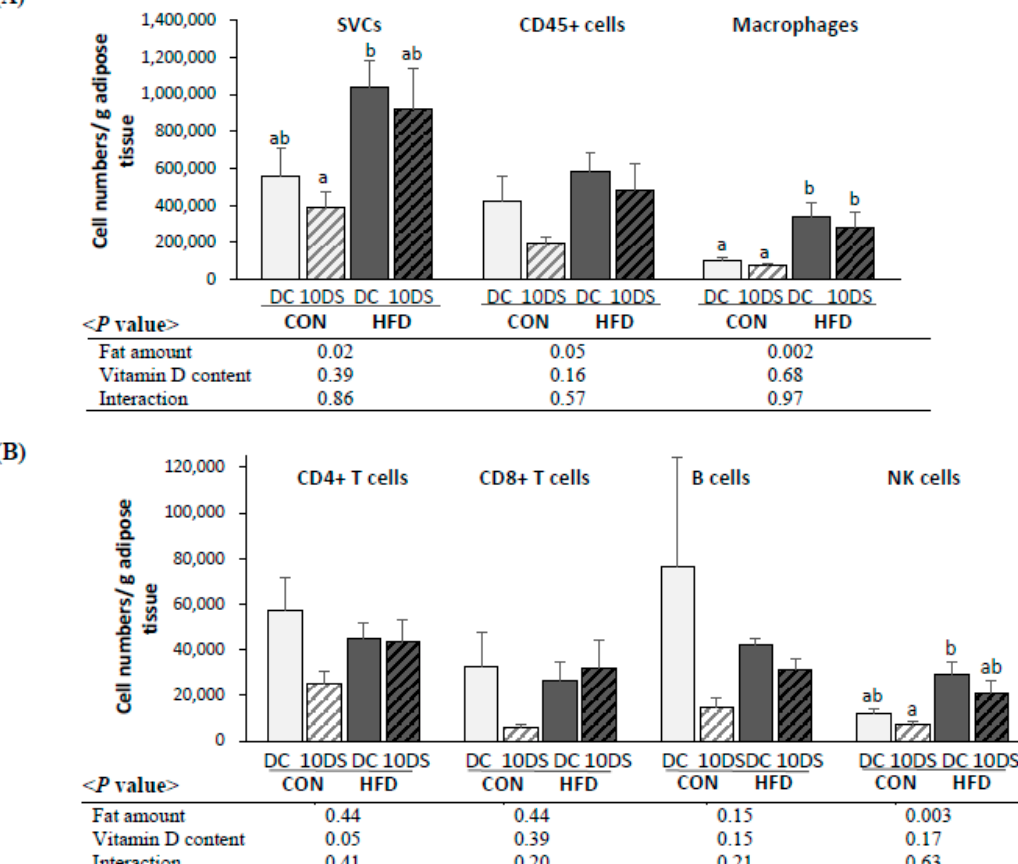
Figure 2. Cell numbers per gram of visceral adipose tissue. ( A ) Stromal vascular cell, CD45 + cell, macrophage, ( B ) CD4 + T cell, CD8 + T cell, B cell, and NK cell. Data are presented as mean ± SEM, n =